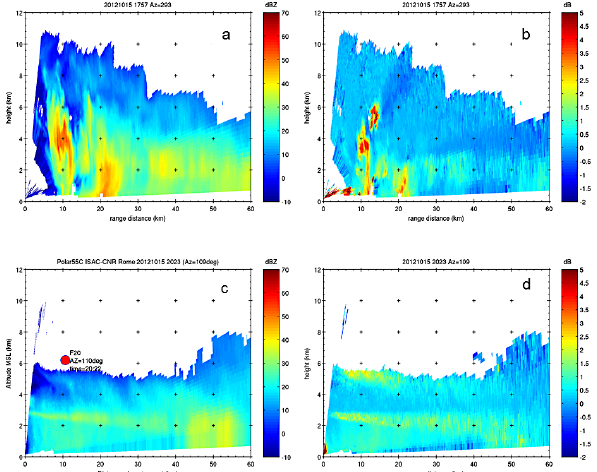
Figure 12. Polar 55C radar in RHI mode on 15 October 2012 (az- imuth 293 ◦ ) at 17:57UTC: (a) sections of reflectivity; (b) differen- tial reflectivity. Polar 55C pointing to a direction along the Falcon 20 route on 15 October 2012 at 20:25UTC: (c) reflectivity; the solid red circle indicates the aircraft position; (d) differential reflectivity.